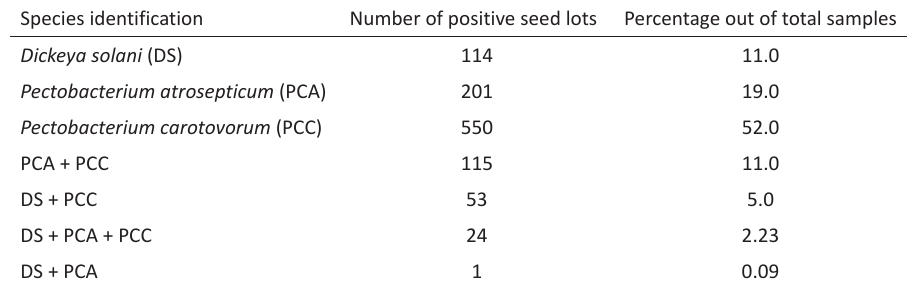
Table 3. Occurrence of latent Dickeya and Pectobacterium species in potato seed lots produced in